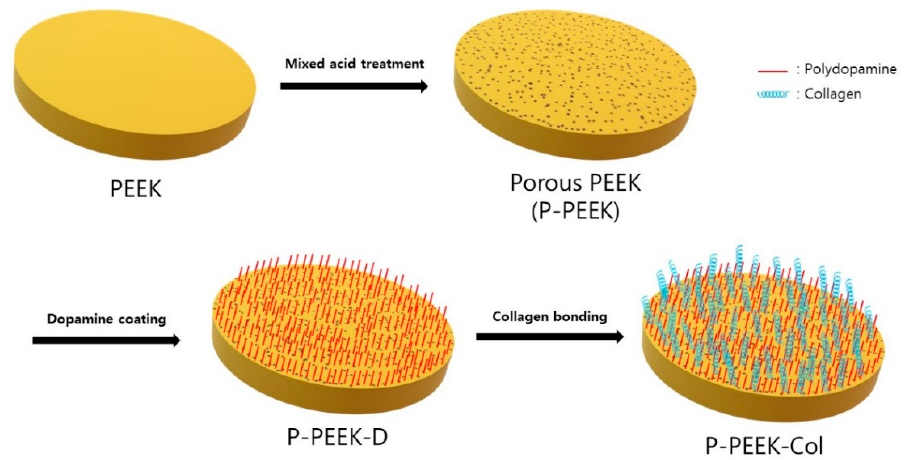
Figure 1. Schematic diagram showing the steps of forming pores by acid-treating PEEK surface and immobilizing collagen following dopamine coating.